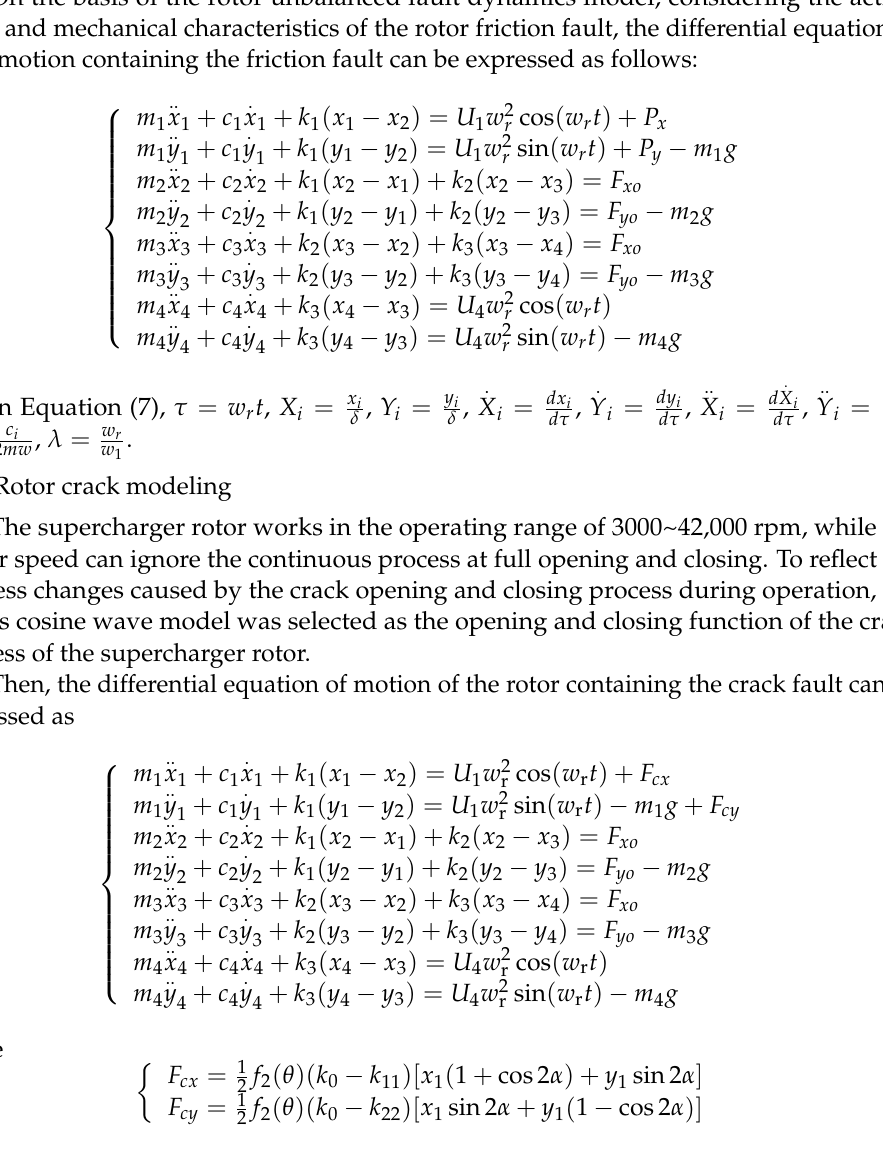
Figure 3. ( a ) Diagram of rub-impact. ( b ) Physical diagram of rub-impact. Assumptions: (1) The rotor speed is considered constant; (2) the displacement of the rotor in the axial direction is negligible; (3) ignore the gyroscopic effect of the rotor; (4) the collision time between the rotor and stator is very short, the deformation of the stator during the collision can be regarded as linear deformation, and the friction force satisfies Coulomb’s law.